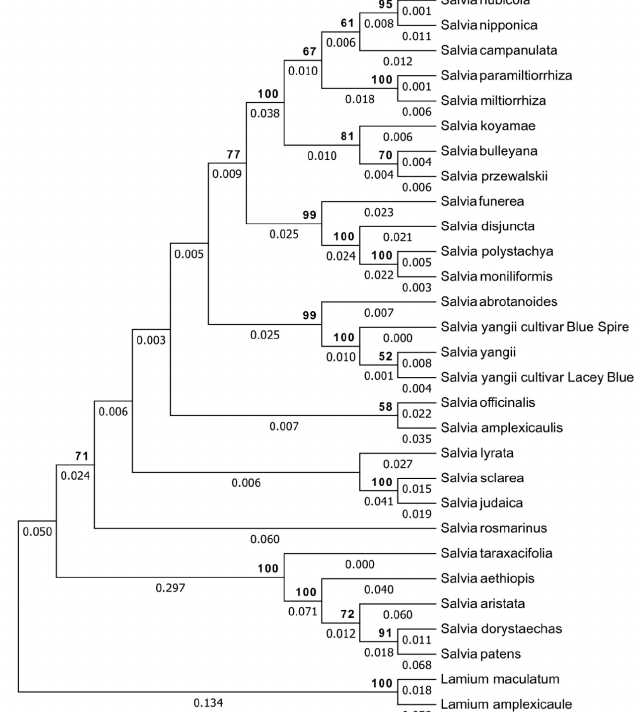
Figure 5. Genetic relationship analysis by the Neighbor-Joining method based on the Maximum Composite Likelihood model and Bootstrap phylogeny test (1000 replicates). Support values are shown above nodes (values lower than 50 are not presented). The branch length is shown below branches. The analysis involved 29 nucleotide sequence combinations. Evolutionary analyses were conducted in